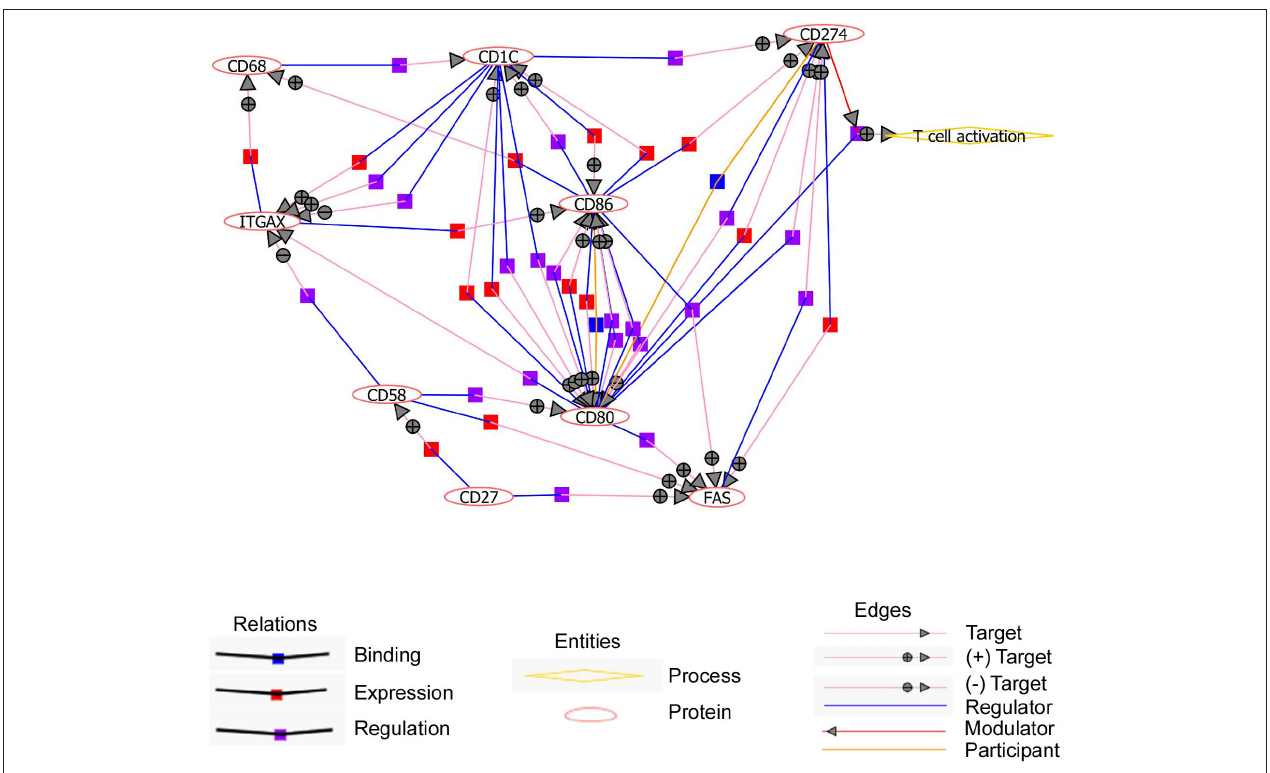
FIGURE 4 | Upregulated cell surface markers on CD11c + B cells interplay to favor T cell activation. Text mining performed with natural language processing (NLP) algorithm shows that 9 out of 12 cell surface receptors are connected all together. Pictograms representing relations, entities, and edges are shown. Circles with + and – symbols represent positive and negative regulations, respectively. Symbols (blue, red, and purple squares) show different modes of relations like binding, expression, and